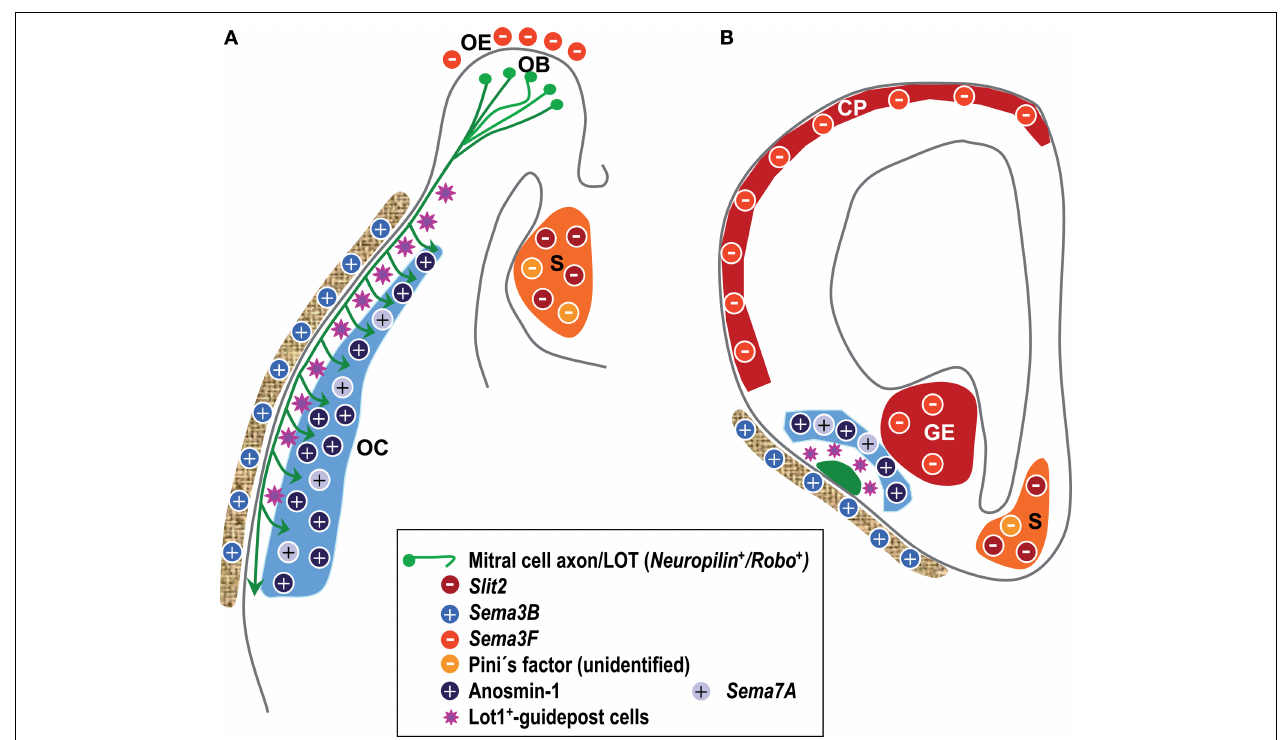
FIGURE 3 | Factors guiding the axonal outgrowth from projection neurons of the olfactory bulb to the olfactory cortex. While (A) represents a horizontal section of the head to show the olfactory structures (OE, OB and OC), (B) represents a coronal one. Mitral and tufted cells and their axons (which form the lateral olfactory tract, LOT) are represented in green. Different chemorepellents (red, orange and brown symbols, with “–” inside) avoid LOT axons to invade different cortical structures (septum, S; ganglionic eminence, GE; and cortical plate,